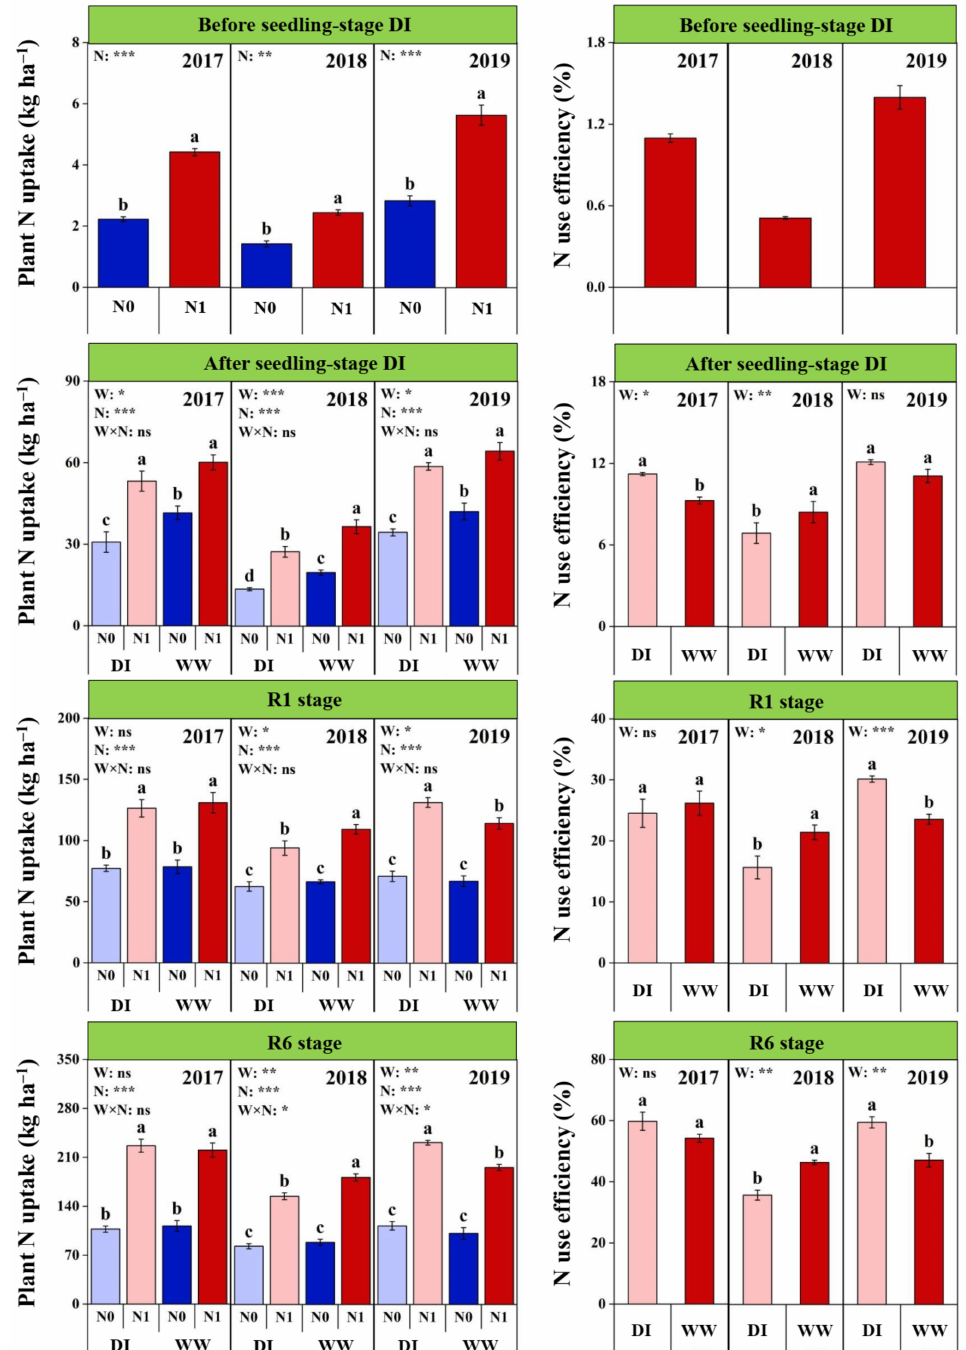
Figure 4. Effects of nitrogen fertilization (N) and seedling-stage water management regime (W) on N uptake and N use efficiency of maize plants at different growth stages in 2017–2019. Note: *, ** and *** indicate significance at p < 0.05, p < 0.01 and p < 0.001, respectively, and ns indi- cates non-significance ( p > 0.05). Different letters above bars indicate significant differences between treatments ( p <